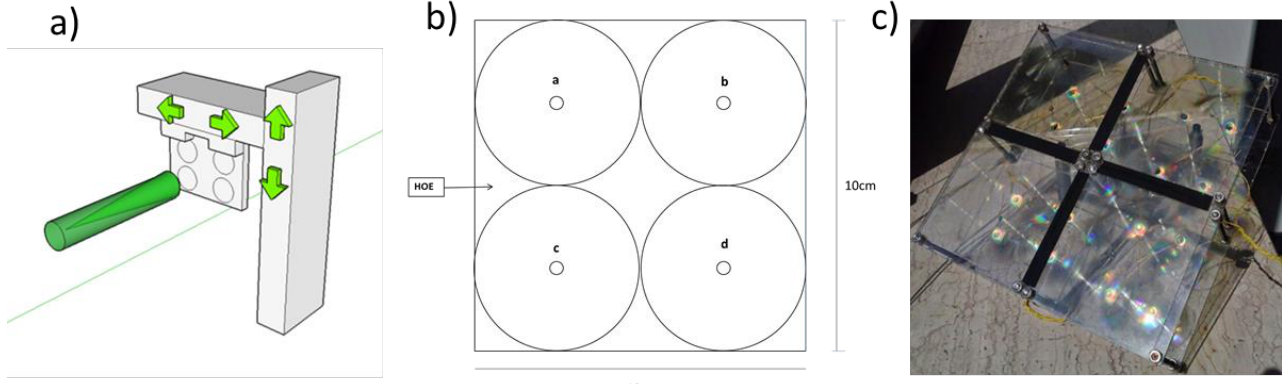
Figure 10. ( a ) Writing system for the recording of array of four lenses on the same glass. ( b ) Array of four lenses recorded on the same glass; ( c ) a prototype of a solar panel obtained combining four glasses with four concentrator lenses recorded on each one.